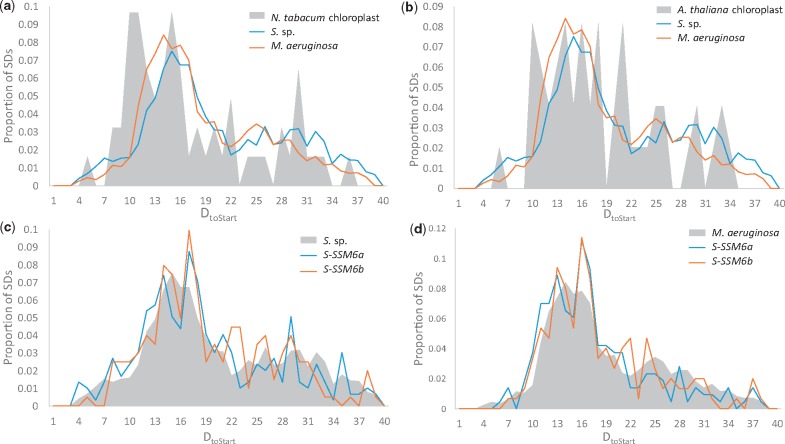
—Comparisons in DtoStart among Cyanobacteria, cyanophages, and chloroplasts. DtoStart constraints differ between Cyanobacteria (S. sp. and M. aeruginosa) and (a) N. tabacum chloroplast and (b) A. thaliana chloroplast. Whereas DtoStart constraints in (c) S. sp. and in (d) M. aeruginosa are well mimicked by cyanophages (S-SSM6a and S-SSM6b). Phage DtoStart in (c) was obtained using S. sp. anti-SD 5′-GAUCACCUCCUUU-3′, and in (d) was obtained using M. aeruginosa anti-SD 5′-GAUCACCUCCUU-3′. Shaded gray are DtoStart constraints for outgroup species subjected to comparison.